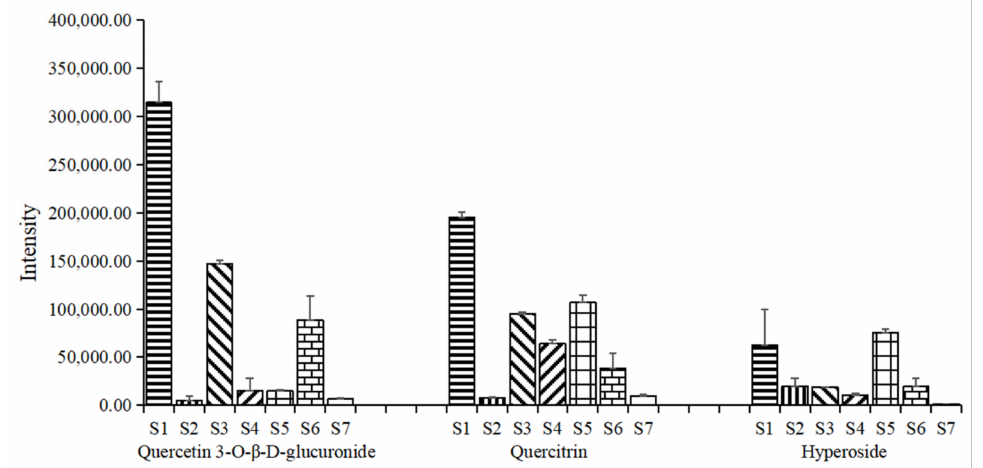
Figure 6. Relative contents of the common differential chemical